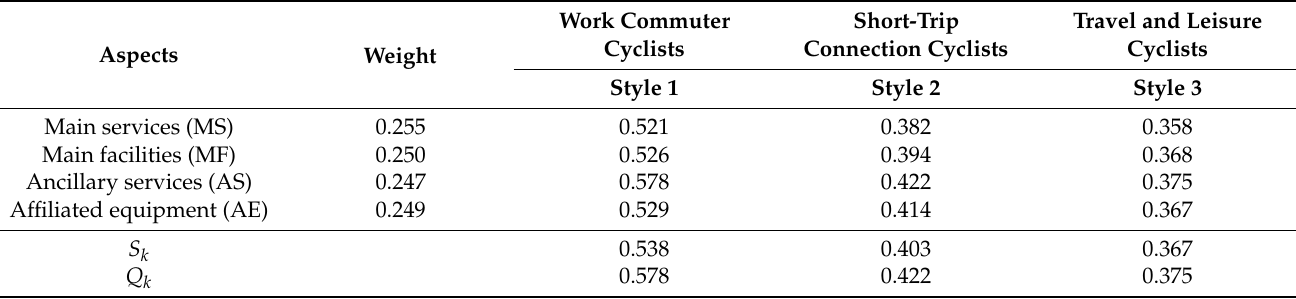
Table 17. The weighted value of the components of f ik .